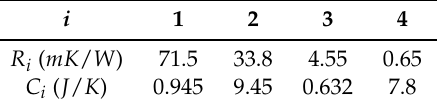
Figure 10. The junction temperatures for the six aging devices. Table 6. The Updated Model